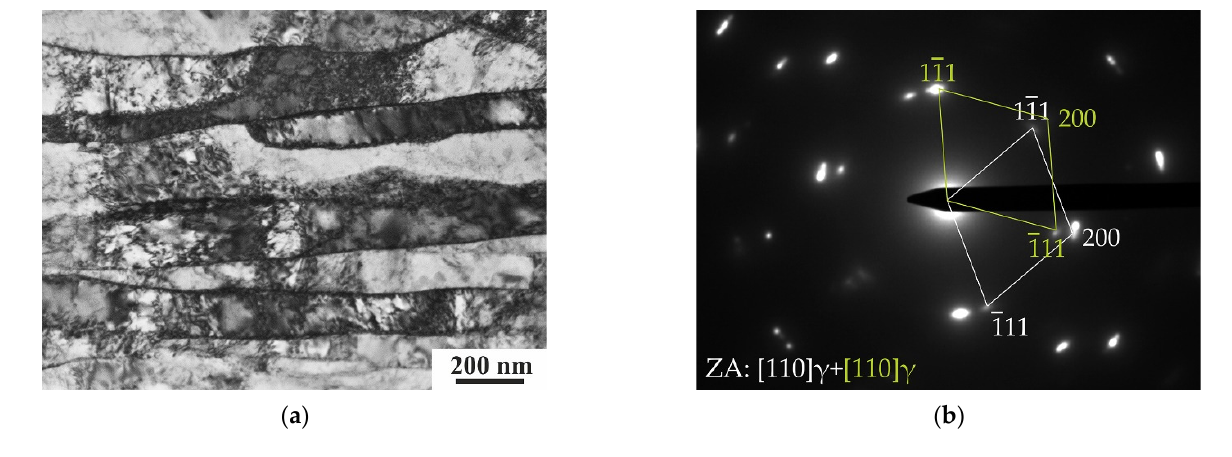
Figure 8. STEM and TEM images of steel microstructure after HTMT-3 + CR in the section perpen- dicular to TD. STEM image of fragmented structure with micro and nanotwins ( a ); BF image with fragmented plates and nanotwins ( b ), Dark-field image in g = 1–11 𝛾 tw ( c ); SAED patterns with ma- trix zone axis [110] γ marked by yellow color and twin zone axis [110] γ tw —by white color ( d ).